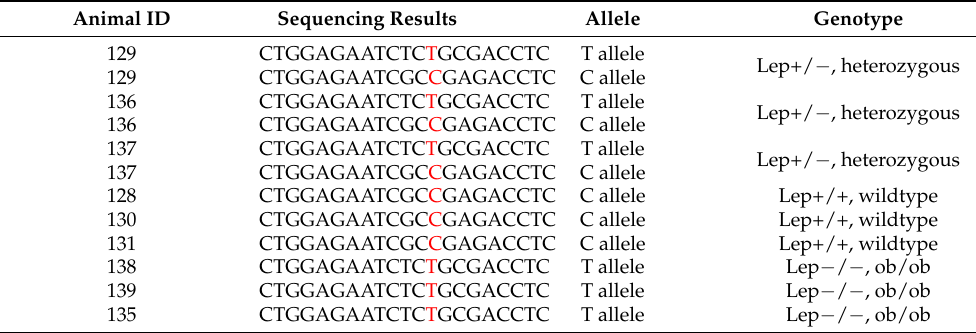
Footnote: Sequencing results of the 253 bp and 171 bp amplicons were from nine mice. Gel bands corresponding to 253 bp or 171 bp from Lep+/+, Lep+/ − or Lep − / − mice, were cut out, purified from the gel with Zymoclean Gel DNA Recovery Kit (Zymo Research, Irvine, CA, USA), and sequenced using an Applied Biosystem 3730 DNA Analyzer (Waltham, MA, USA) following Applied Biosystems BigDye Terminator v3.1 recommendations. Sequencing results of amplicon band size of 253 bp were produced using Reverse Outer as the primer. Sequencing results of amplicon band size of 171 bp were produced using Forward Outer as the primer. Red colored letter: T (Thymine); C (Cytosine).